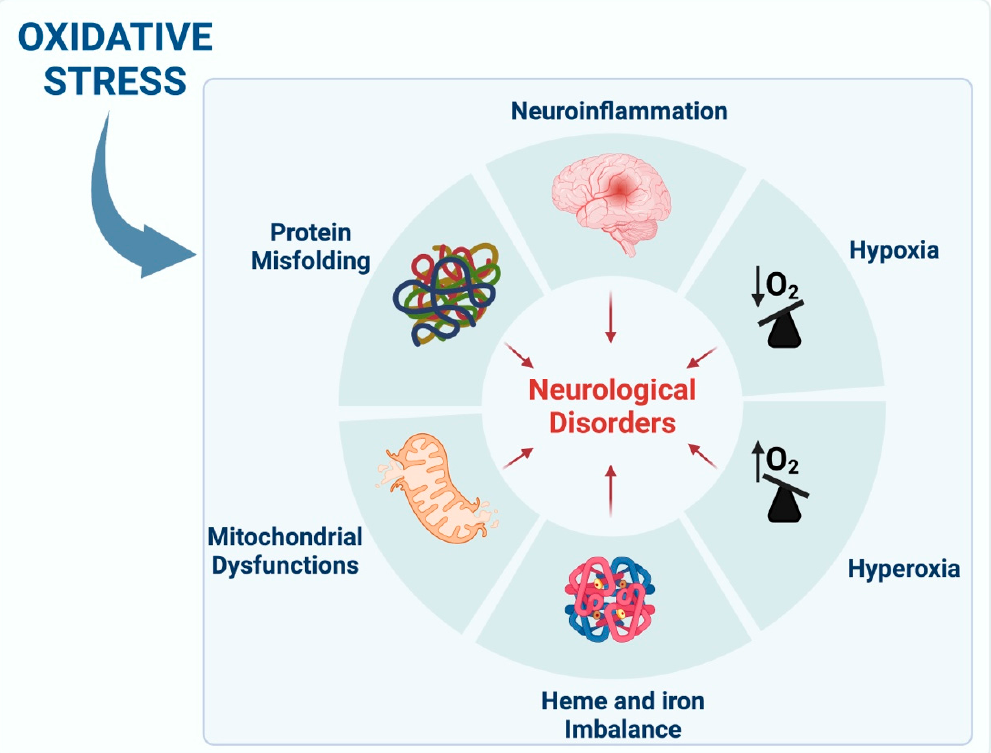
Figure 1. Schematic representation of the alterations in redox mechanisms that can lead to numerous aberrant processes, and ultimately lead to neurological